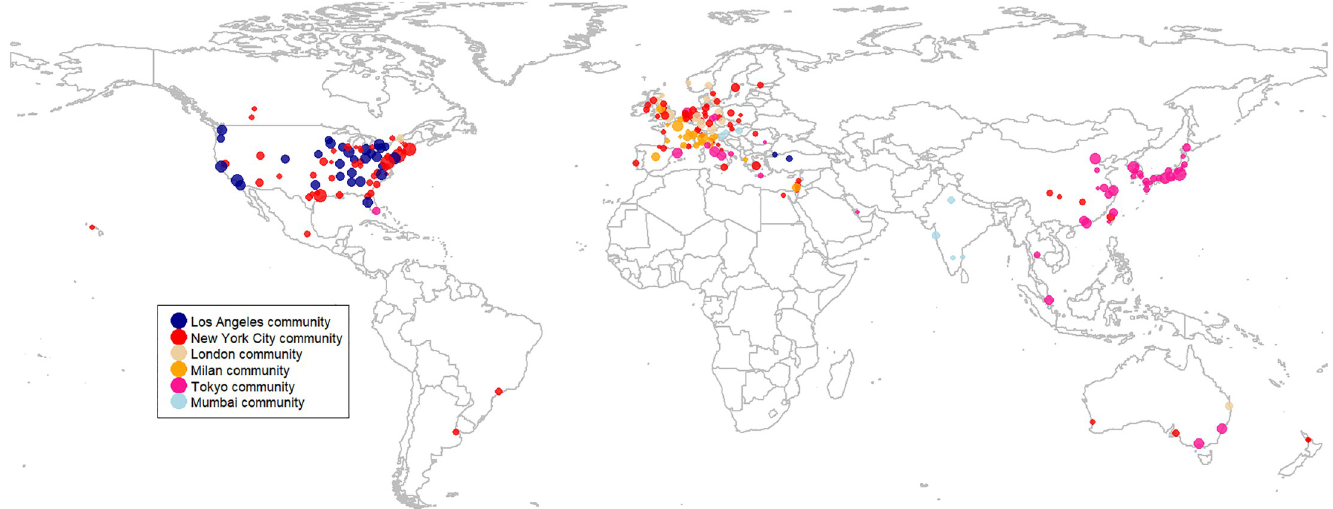
Fig 2. Mapping cities constituting the network by communities. Node colors represent the communities to which the cities belong. Node size is proportional to the number of editors resident in the city (log-transformed). Created by own data, with base map of Natural Earth licensed as CC BY.